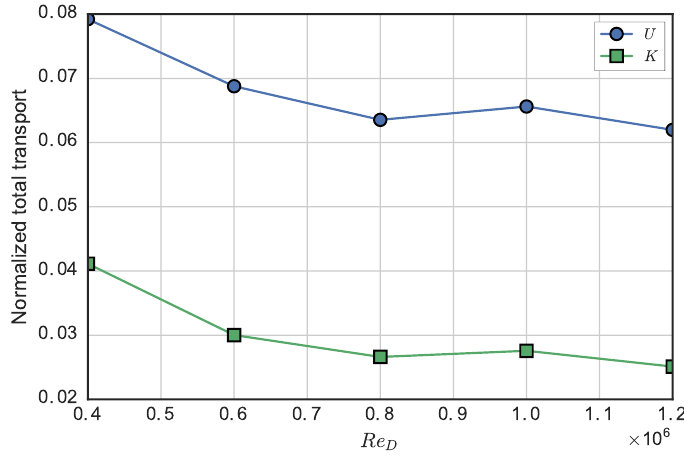
Figure 16. Normalized transport totals from Figures 14 (streamwise momentum, U ) and 15 (mean kinetic energy, K ) plotted versus the Reynolds